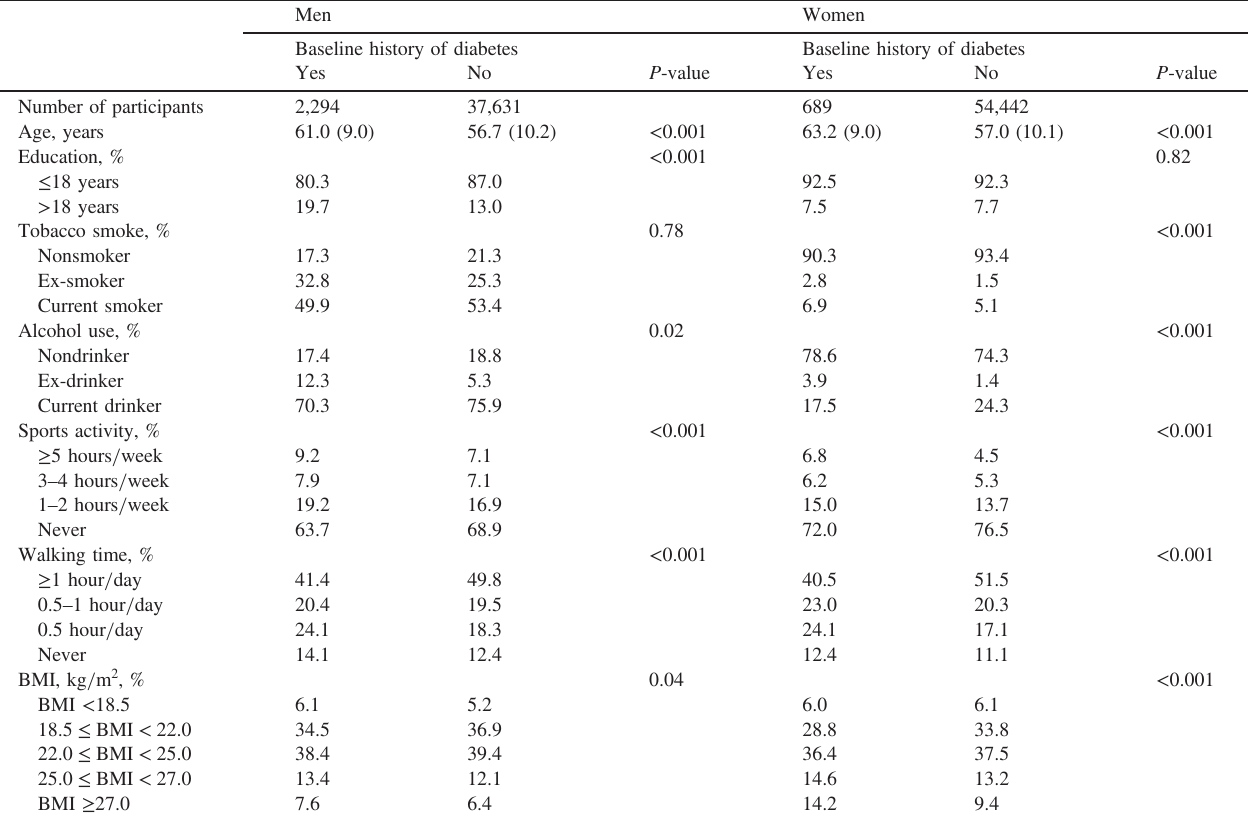
BMI, body mass index.